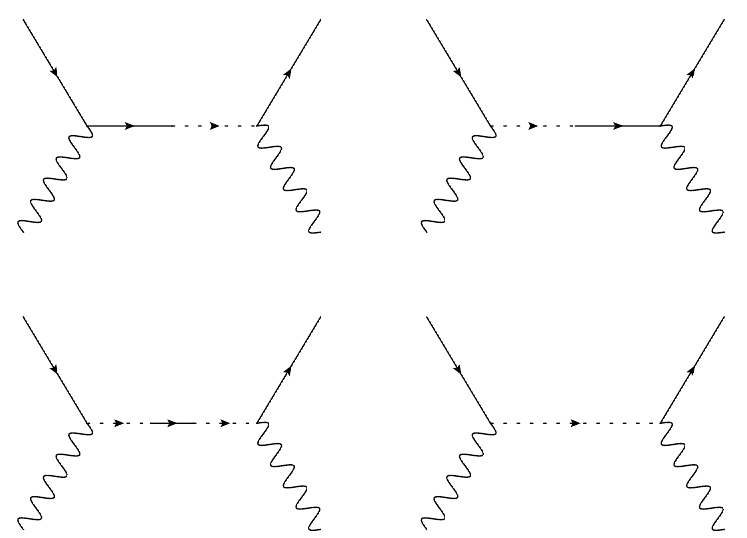
Figure 2 . Massive exchange diagrams that involve non-diagonal propagators. The solid line is the physical spin- 5 / 2 field and the dotted line the auxiliary spin- 1 / 2